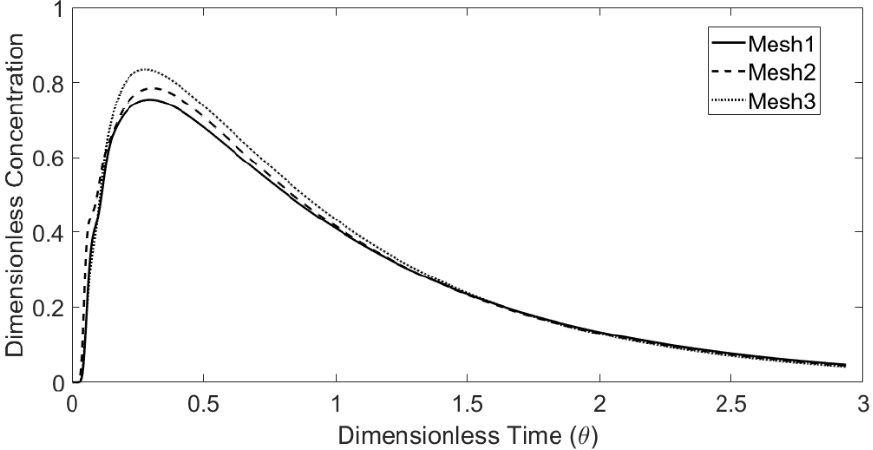
Figure 5. Comparison of calculated E-curves with different CFD mesh size (mesh size: Mesh1—0.002 m; Mesh2—0.003 m and Mesh3—0.004 m).